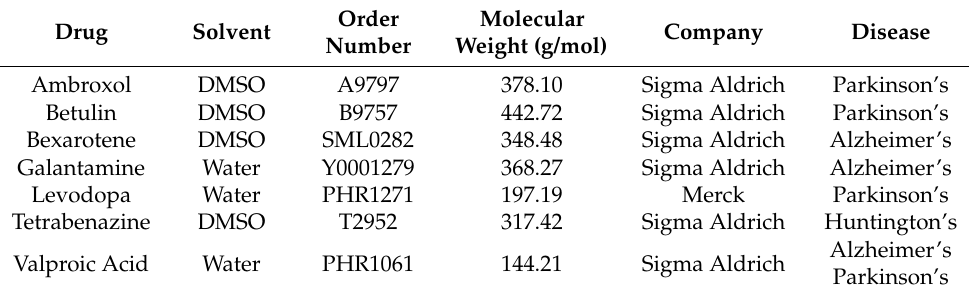
Table 2. Small-molecule inhibitors used in the